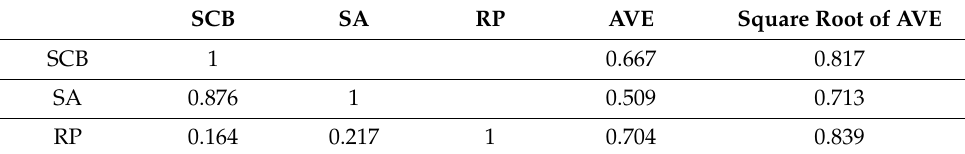
Table 6. The testing results of discriminant validity among RP, SA and